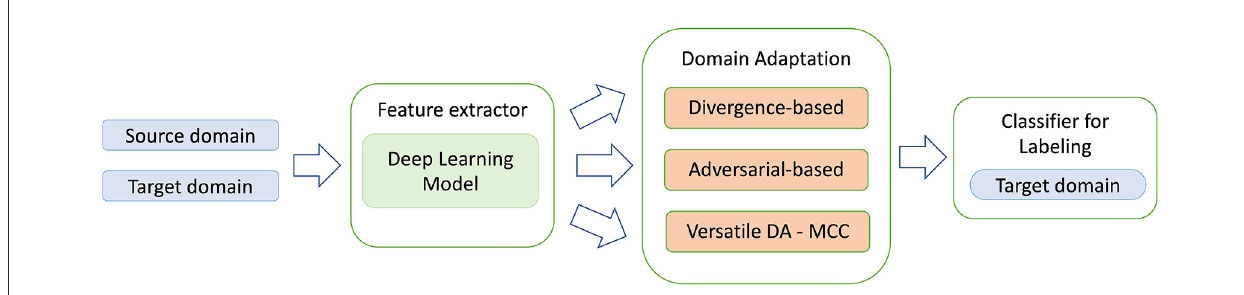
FIGURE3 Schema of a Baseline Deep Learning Model for prediction of TF and HM